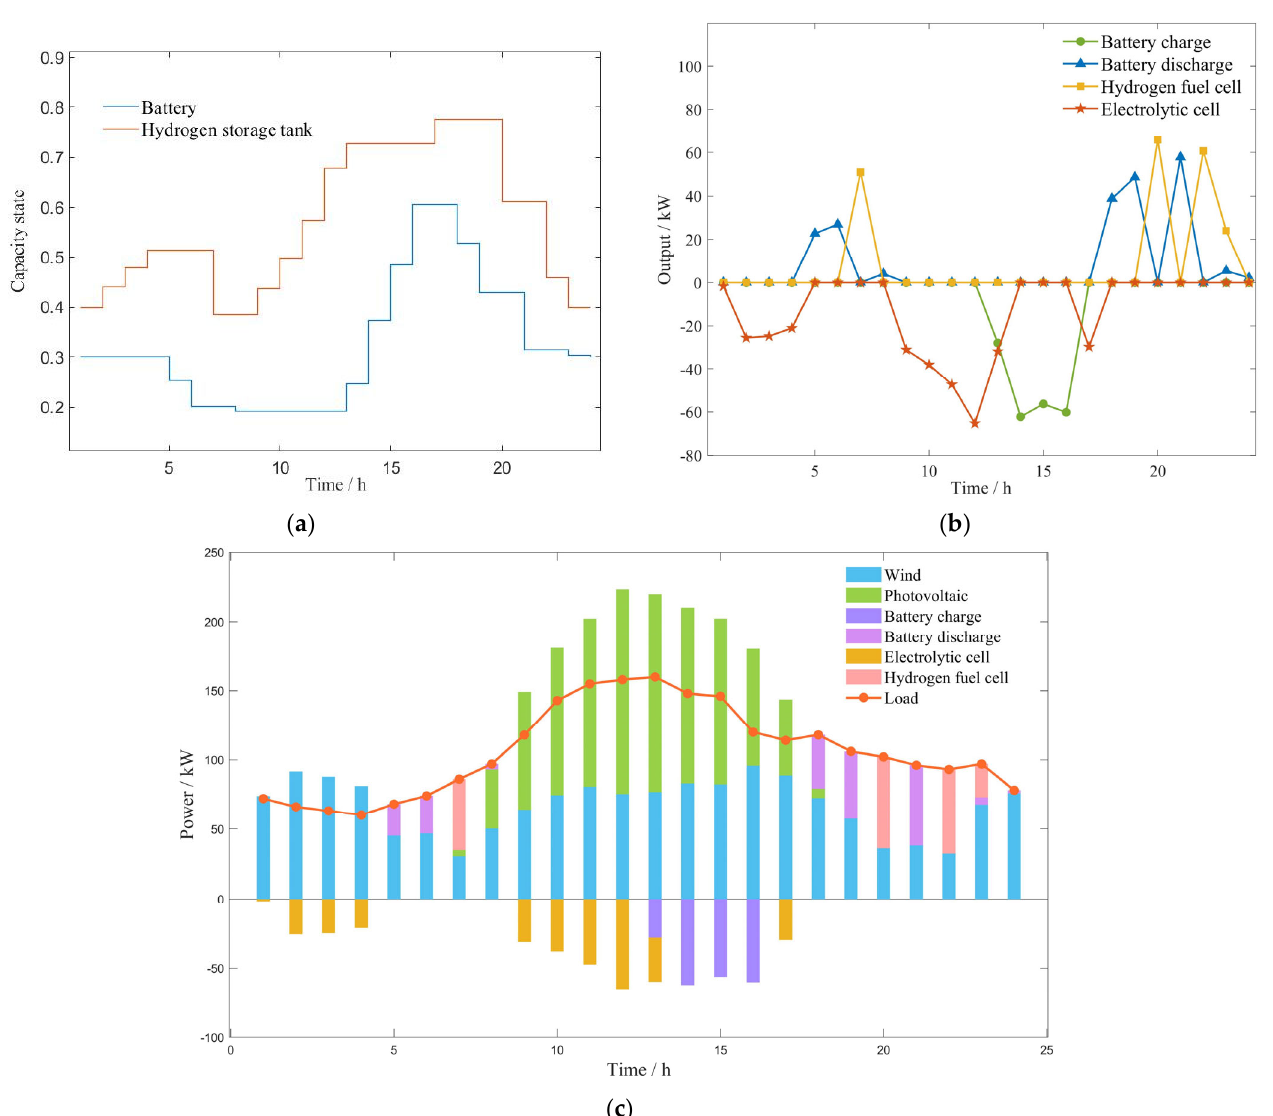
Figure 8. ( a ) Day − ahead optimal scheduling system capacity status; ( b ) Day − ahead battery and hydrogen energy storage system output; ( c ) Day − ahead optimal scheduling result.